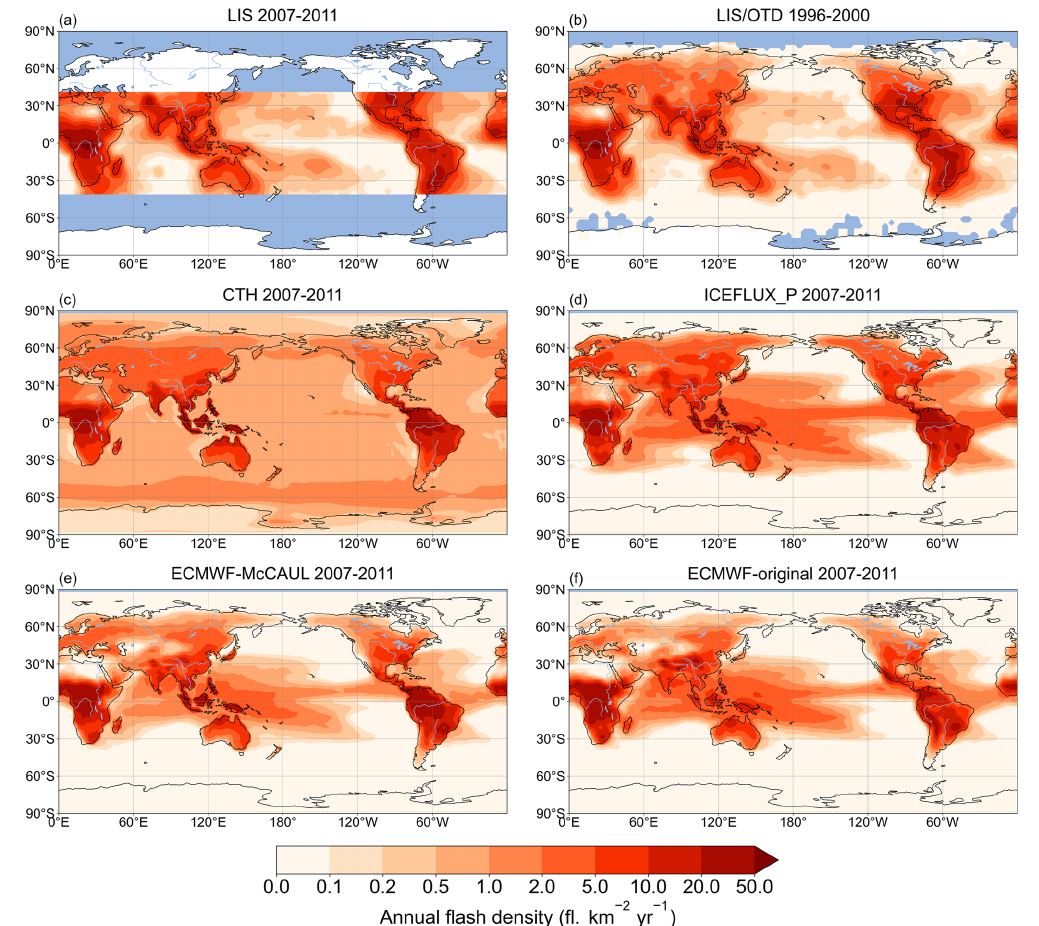
Figure 2. Annual mean lightning flash densities from (a) LIS satellite observations spanning 2007–2011, (b) LIS/OTD satellite observations spanning 1996–2000 but with a wider range, (c) the CTH scheme in 2007–2011, (d) the ICEFLUX_P scheme in 2007–2011, (e) the ECMWF- McCAUL scheme in 2007–2011, and (f) the original ECMWF scheme in